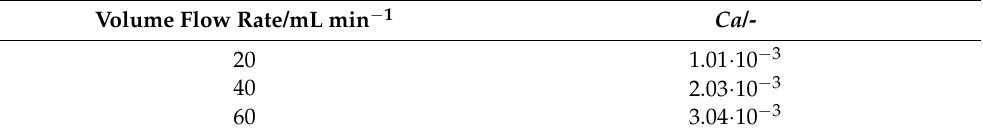
Table 2. Calculated Ca numbers for the respective volume flow rates used in the considered